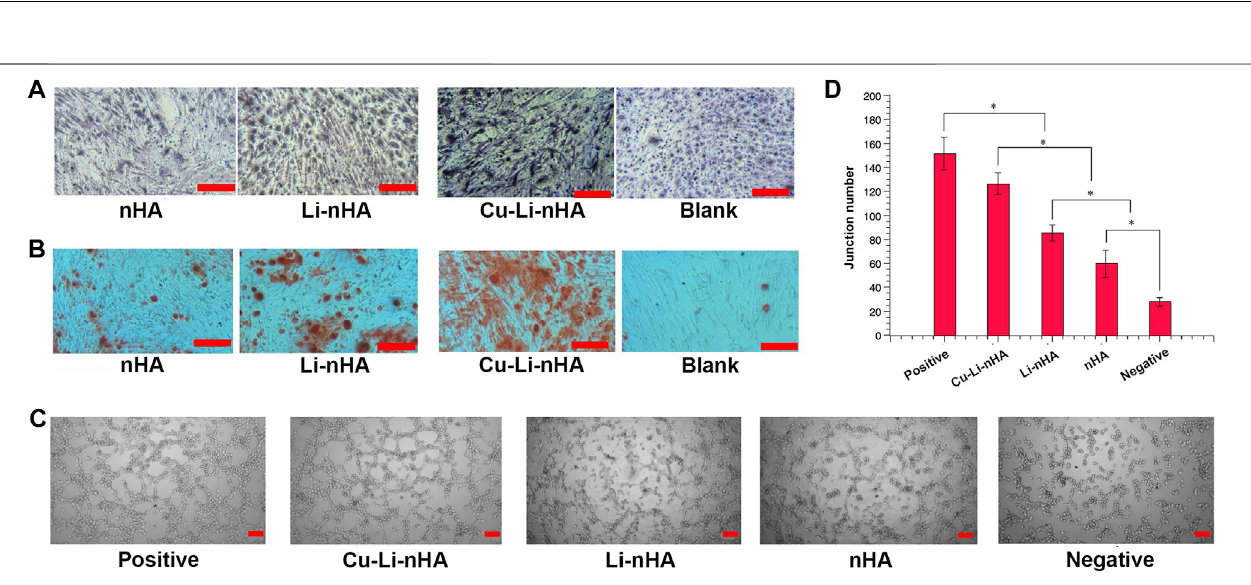
FIGURE 4 | (A,B) Osteogenic differentiation tests. (A) Alkaline phosphatase staining among groups. Light or dark purple staining cells represent positive cells. (B) Alizarin red S staining among groups. The red areas or dots represent calcium nodules or deposits. Blank Group: complete medium. Scale bar in the bottom right-hand corner of each image (red): 200 μ m. (C,D) Tube formation assays for angiogenesis test. (C) Tube-like structure represents newly formed vessel. Scale bar inthe bottom right-hand corner of each image (red): 200 μ m. (D) The number of tube-like structures among different groups. Positive Group: VEGF + complete